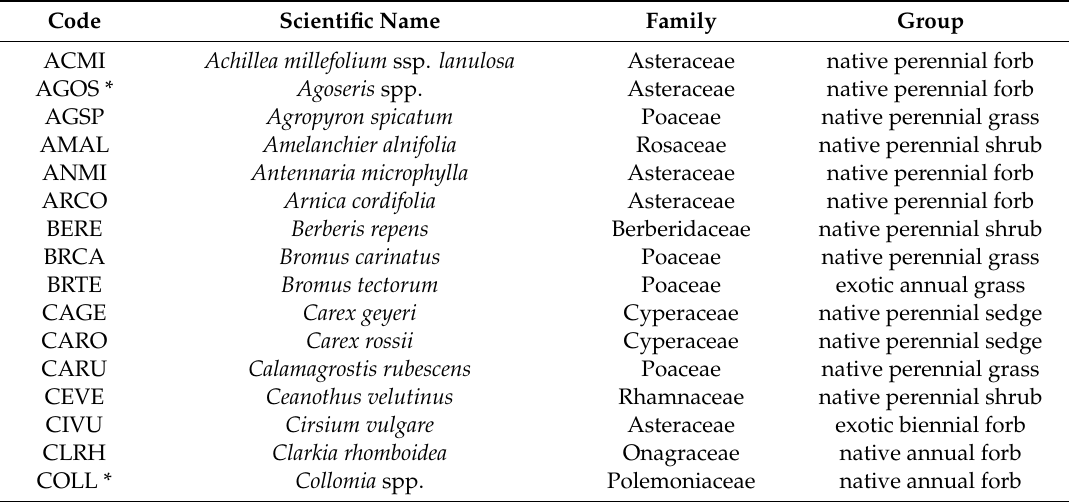
Table A1. Species codes, scientific names, and general groups for all understory plant species used in analyses. * after species codes denotes species groups or